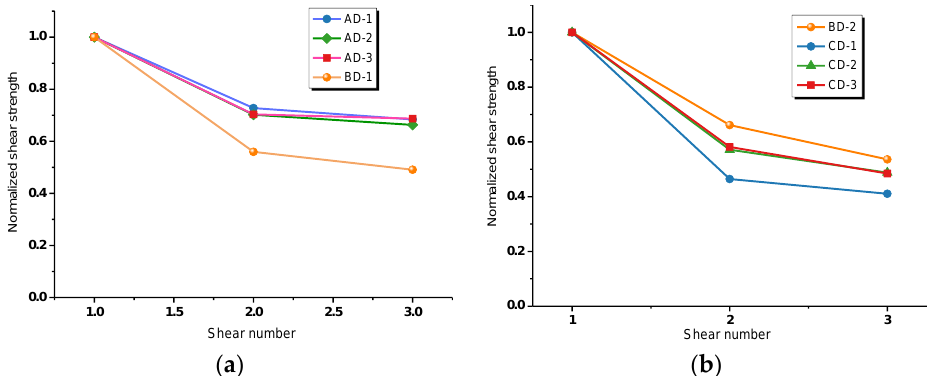
Figure 8. Normalized relationship between shear strength and shear times. ( a ) Normal stress = 4 MPa; ( b ) Normal stress = 2 MPa.